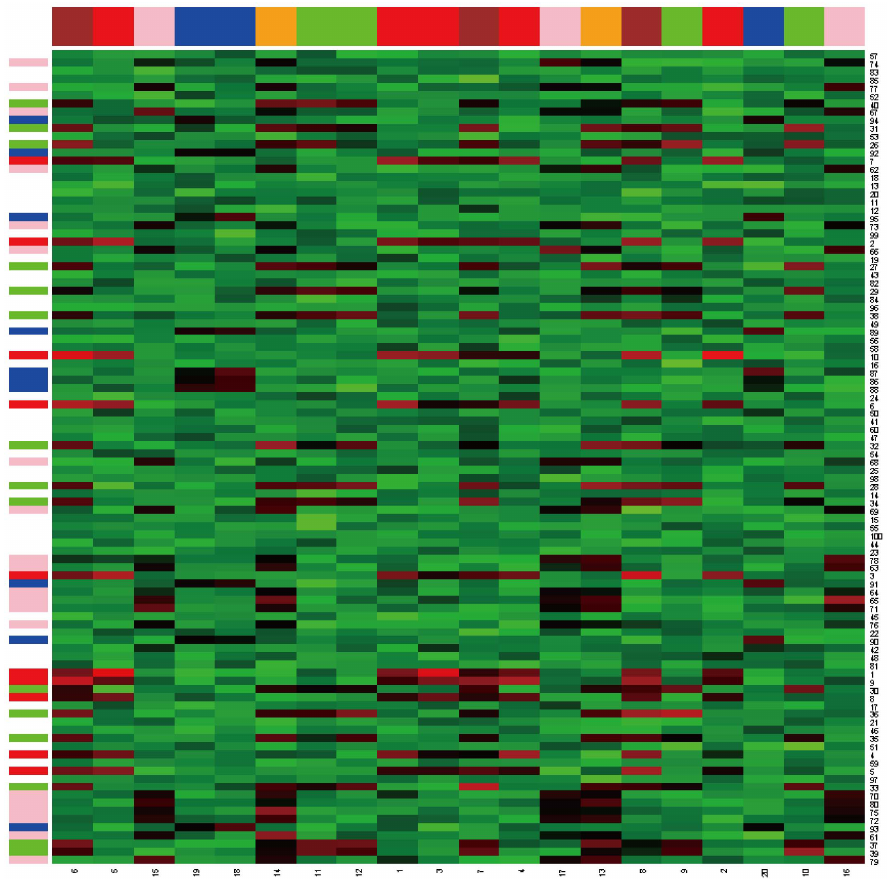
Figure 4. Heatmap of the randomly permuted synthetic data from Figure 3. This reflects the real data collected from an experiment.